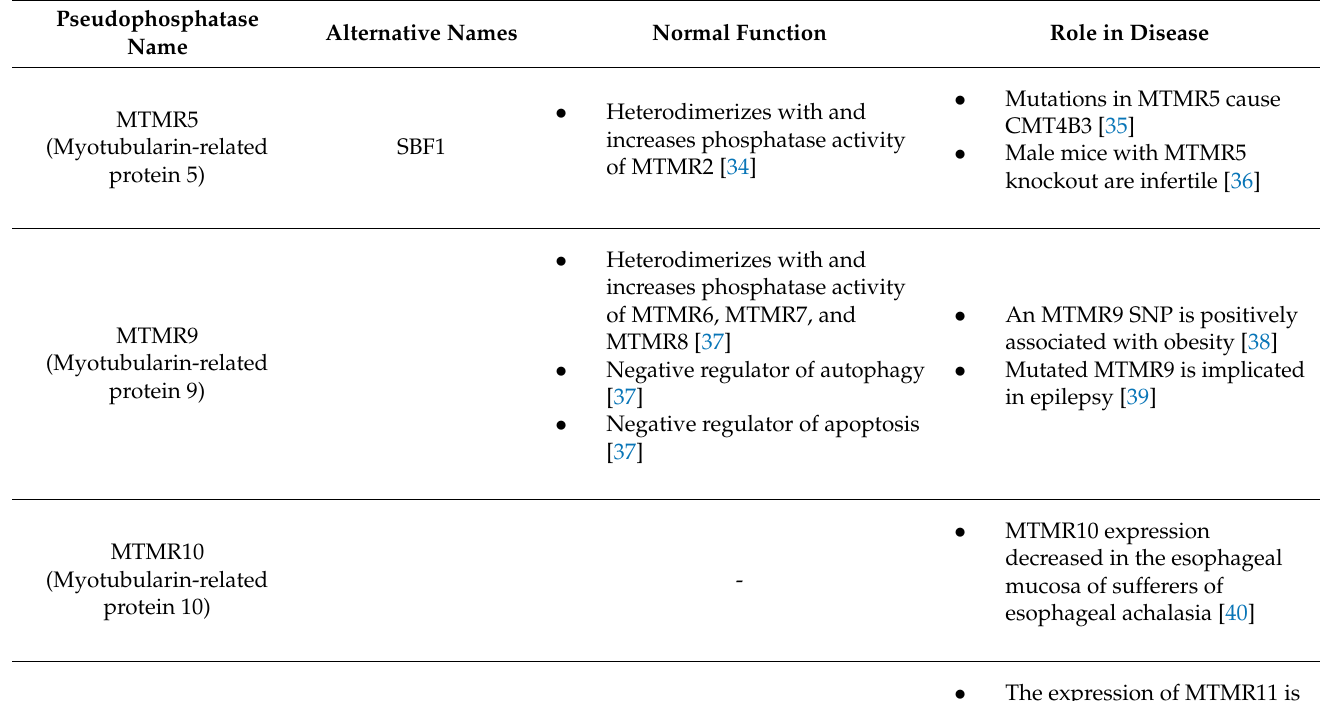
Table 1. Pseudophosphatase Functions and Roles in